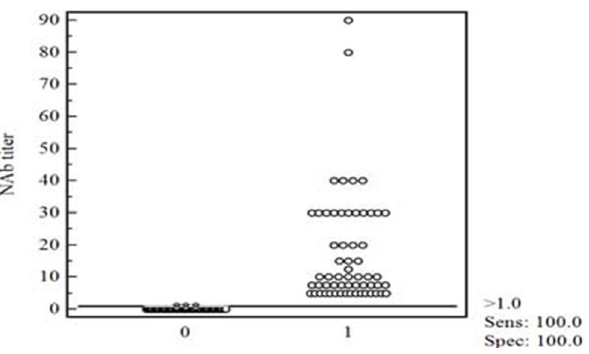
Fig. 5. Interactive dot diagram for the neutralization test using rHPRS-103EGFP. Interactive dot diagram of NAbs titers from samples (n 5 110) detected by NT-EGFP relative to the samples in parallel detected by NIT. The cutoff value of NT-EGFP was 1. The NAb titer is the reciprocal of the highest dilution. ‘‘0’’ stands for the negative results detected by NIT and ‘‘1’’ stands for the positive results detected by